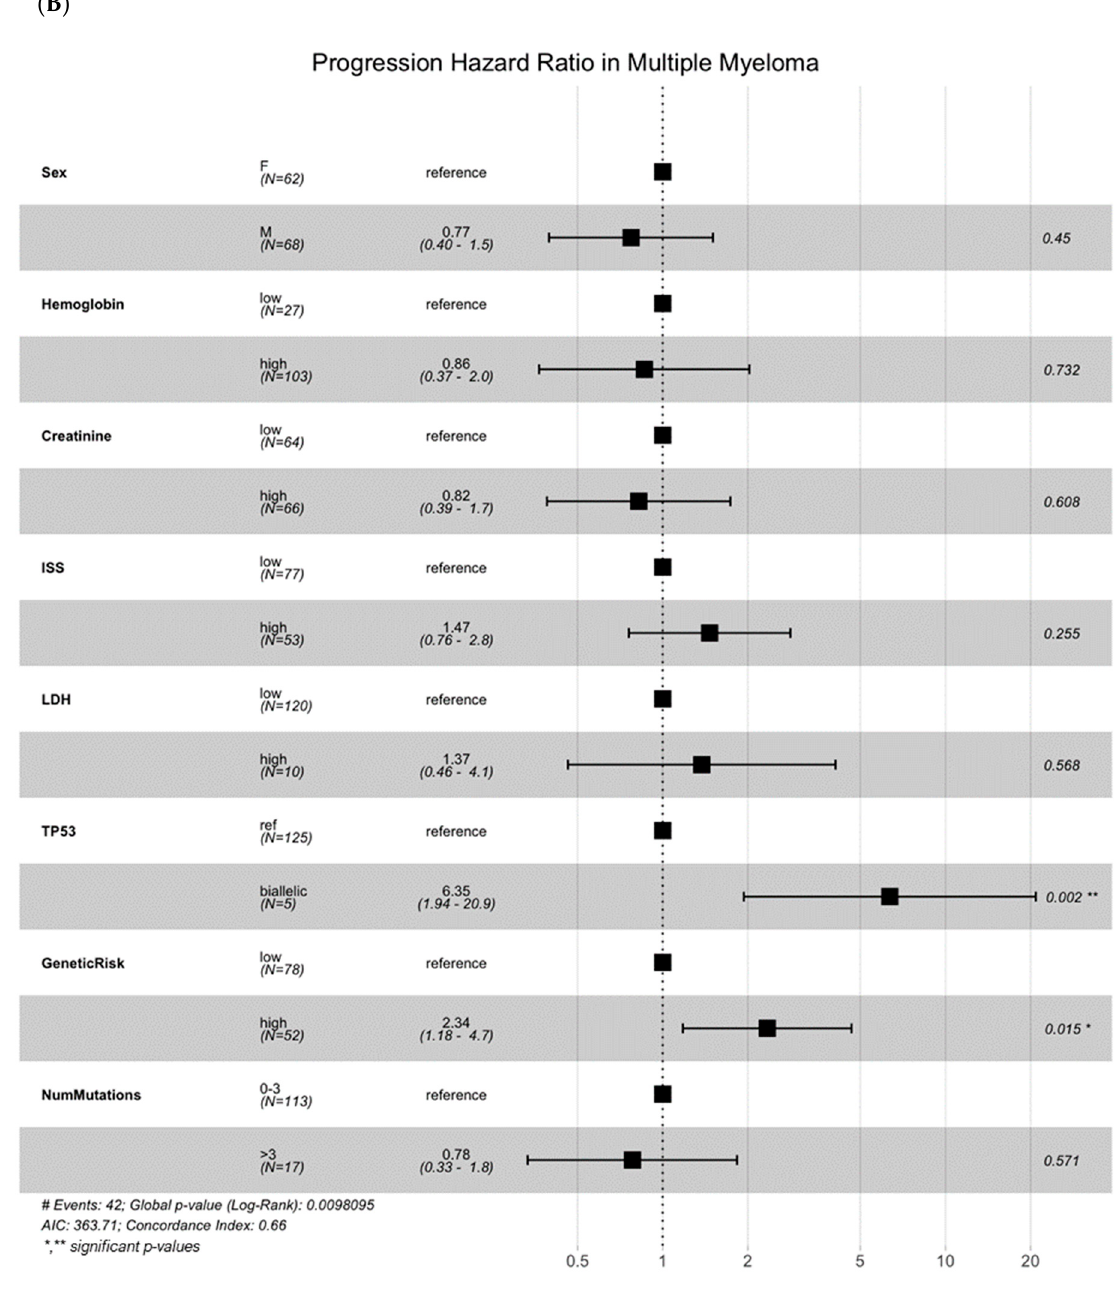
Figure 2. Impact of specific alterations on the progression of MM. ( A ) Univariate survival analysis (Kaplan–Meier plots). TP53 mutations and high-risk by NGS plots are shown at the top; del(17p) identified by NGS or FISH plots are shown in the middle; and gain(1q) identified by NGS or FISH plots are shown at the bottom. ( B ) Multivariable analysis using coxph and ggforest functions. Selected values were sex, hemoglobin (high > 9 g/dL), creatinine (high > 1 mg/dL), International Staging System stage (high = ISS III), LDH (lactate dehydrogenase, high = abnormal), TP53 mutational status, genetic high-risk, and total number of mutations.